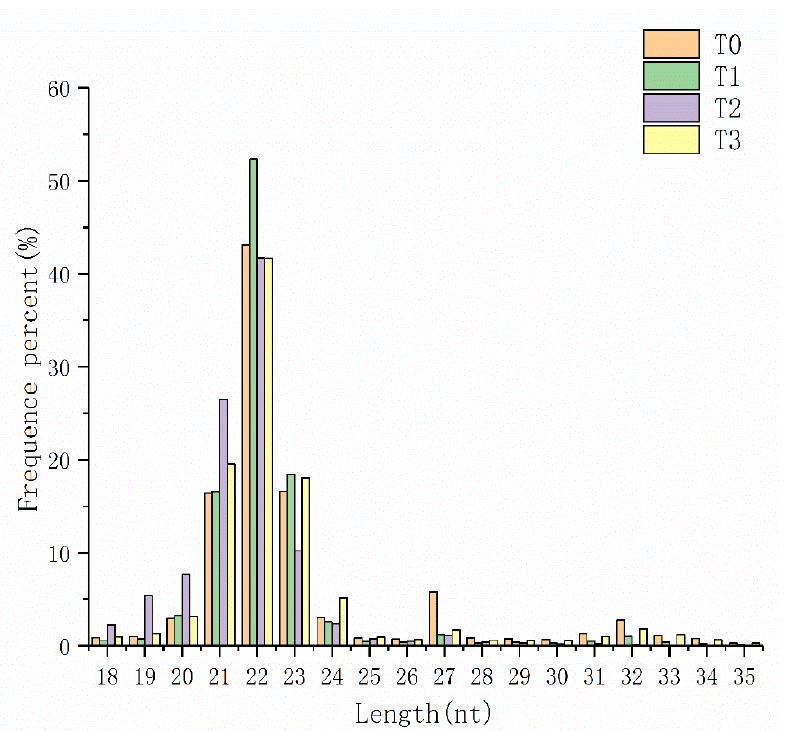
Figure 1. Distribution statistics of small RNA fragment length in four samples. X-axis represents the length distribution of small RNA in T0, T1, T2 and T3 group. The Y axis represents the percentage of each length of small RNA. MiRNAs of 22 nt in length were the most common type. Table 3. Highly expressed miRNAs in different groups.